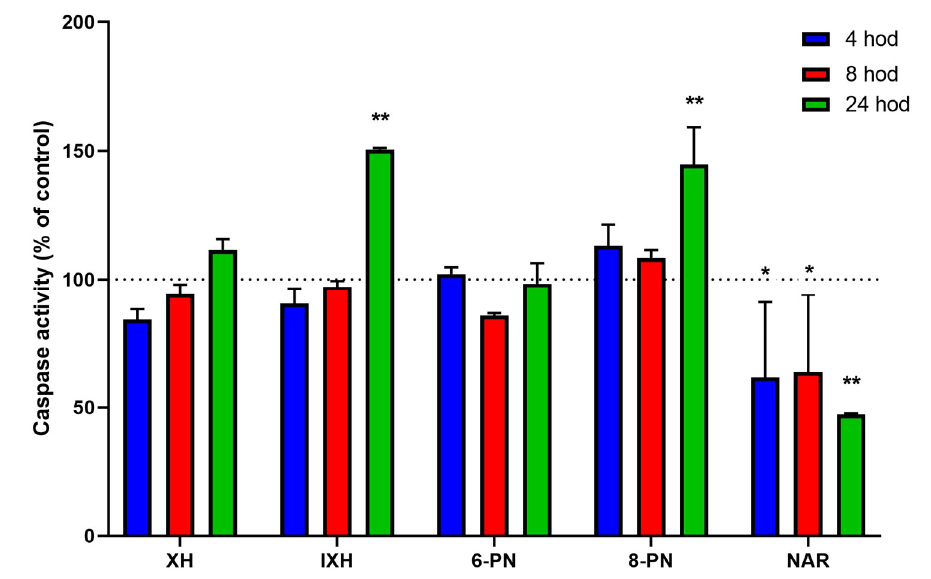
Figure 4. E ff ect of prenylflavonoids and naringenin on the activation of apoptosis in SW620 cells. The activity of caspases-3 / 7 was assessed after 4-, 8-, and 24-hour incubation. Data presented as percentage of untreated control ( = 100%), represent the mean ± S.D. ( n = 3) (* data with p < 0.05, ** p < 0.001, one-way ANOVA with Dunett’s test).